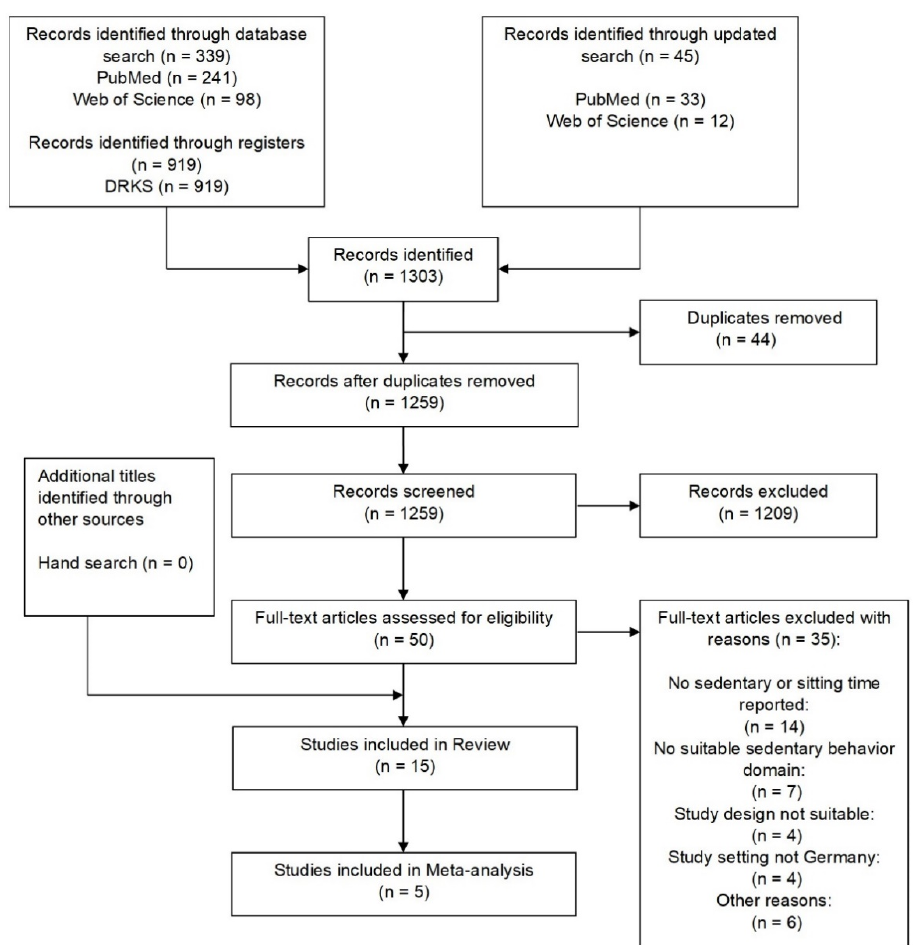
Figure 1. PRISMA flow diagram depicting the process of study selection. n = number of articles. DRKS = German Clinical Trials Register.